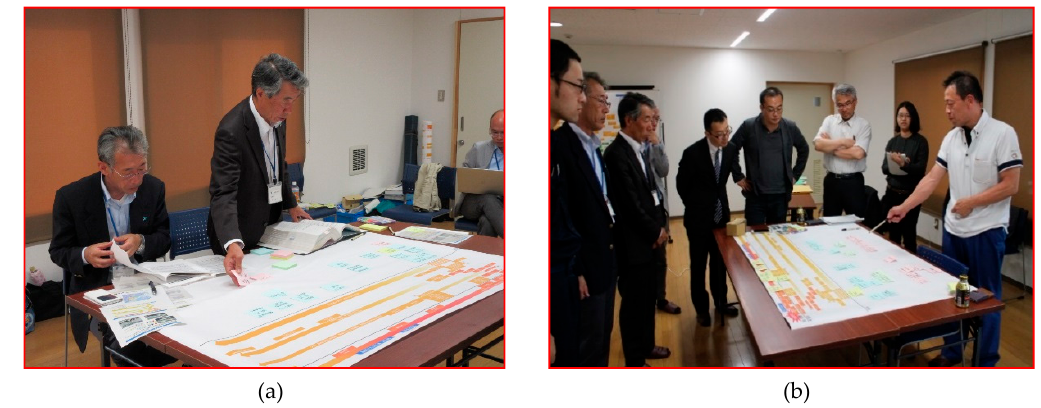
Figure 5. The workshop confirming a current disaster management plan. ( a ) This photograph shows the creation of the timeline for Isumi-shi; ( b ) This photograph shows discussion on the timeline of Kamogawa-shi.